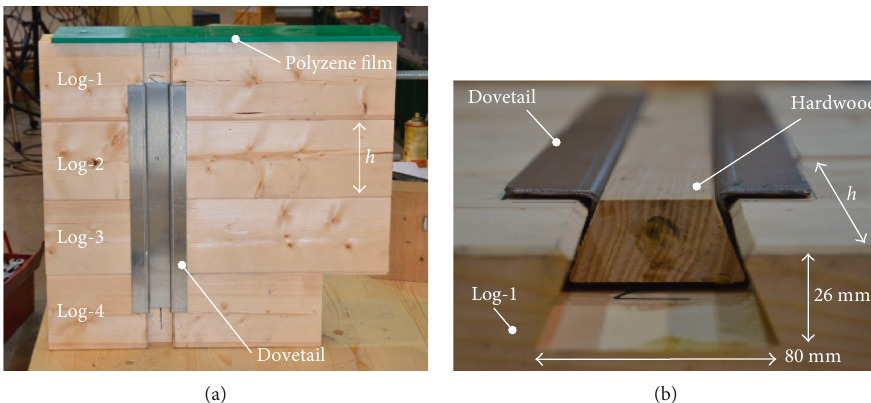
Figure 2: Reference experimental tests, showing (a) a typical small-scale specimen (front view) and (b) a steel dovetail reinforcement (“S02” specimen, top view), in accordance with